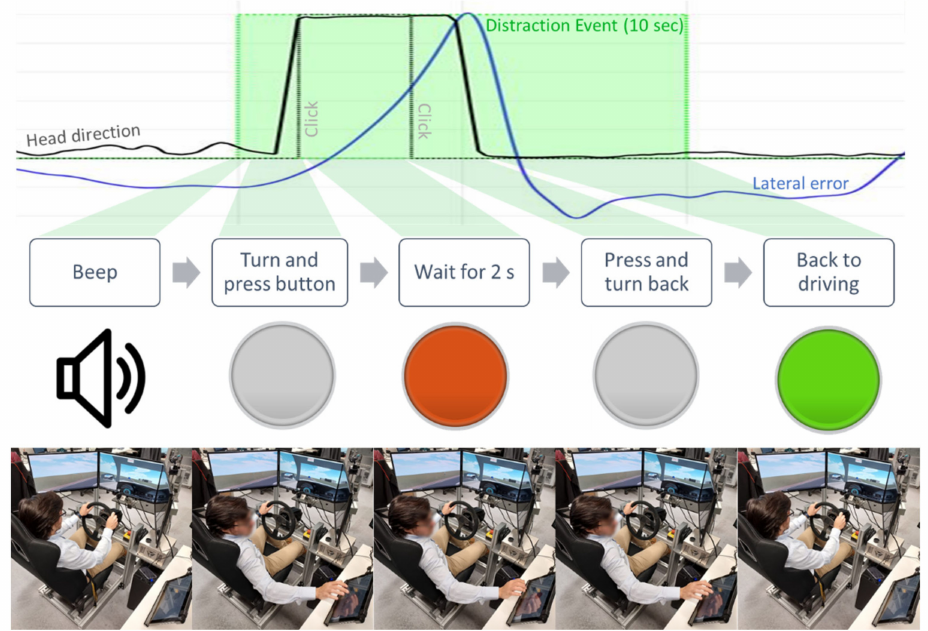
Figure 7. Distraction event sequence that represents the secondary task of the driving experiment.